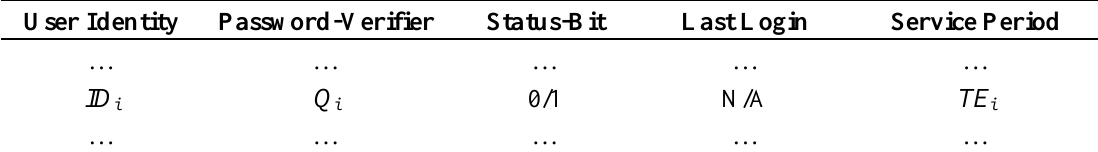
Table 2. The identity table of GWN after finishing the registration phase.